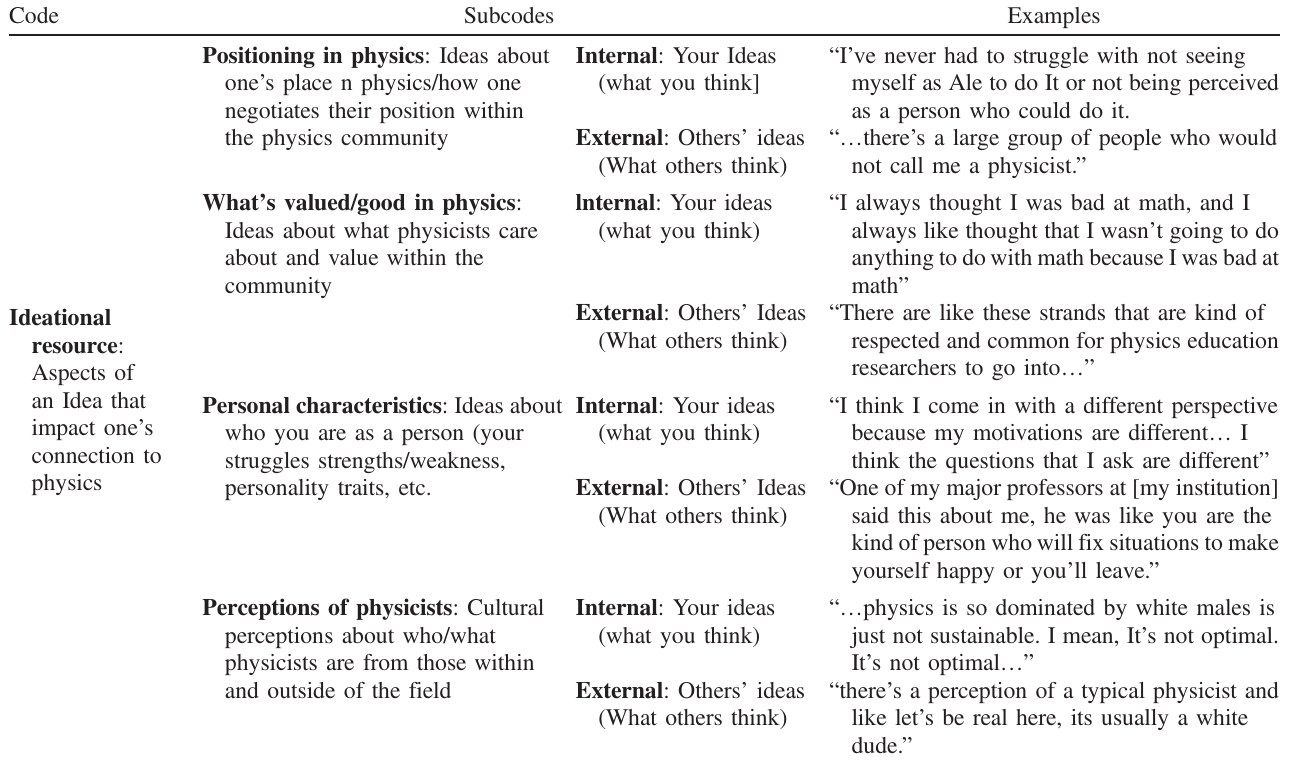
TABLE II. Details of our ideational resource construct code definitions. This includes the definition of the main construct, as well as the definitions of each subcode and example from the interviews of Cara, Jeff, Cindy, or Owen.